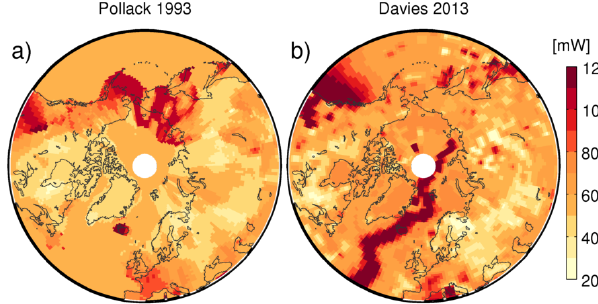
Figure 2. Geothermal heat flux from (a) Pollack et al. (1993) and (b) Davies